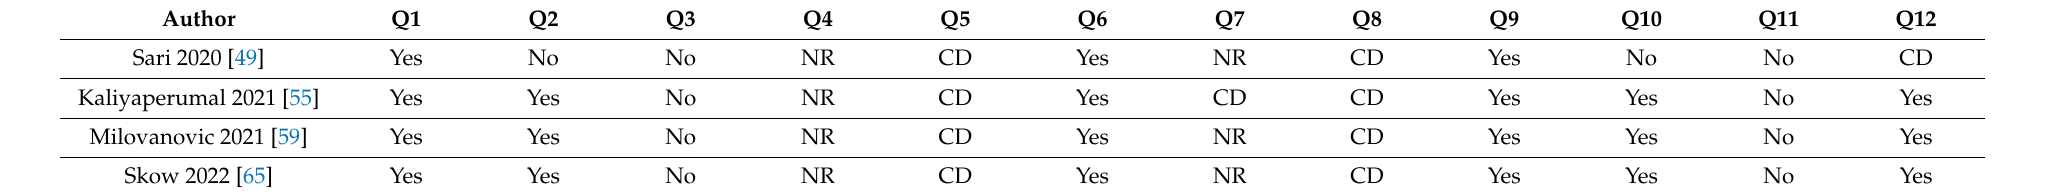
Table 2. Methodological qualities of included case-control